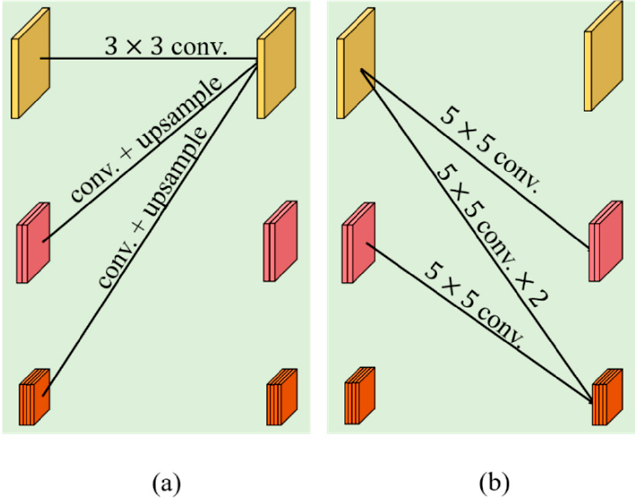
Figure 5. Illustration of exchanging the information across multi-resolution representations. ( a ) Low-resolution representations to high-resolution representations. ( b ) High-resolution representations to low-resolution representations.